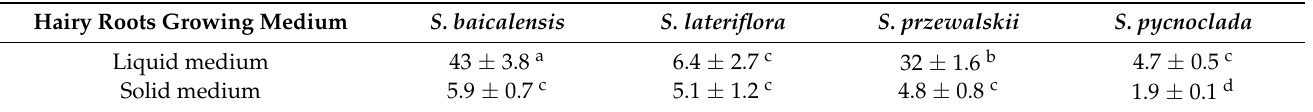
Values are presented as the means ± SD and different letters represent significant differences at p ≤ 0.05 according to one-way ANOVA.